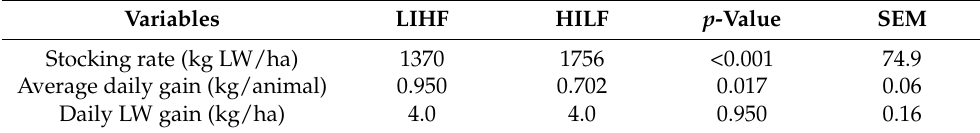
Table 3. Stocking rate and performance of beef cattle grazing sorghum pastures under different grazing management strategies (LIHF and HILF). Variables LIHF HILF p -Value SEM Stocking rate (kg LW/ha) 1370 1756